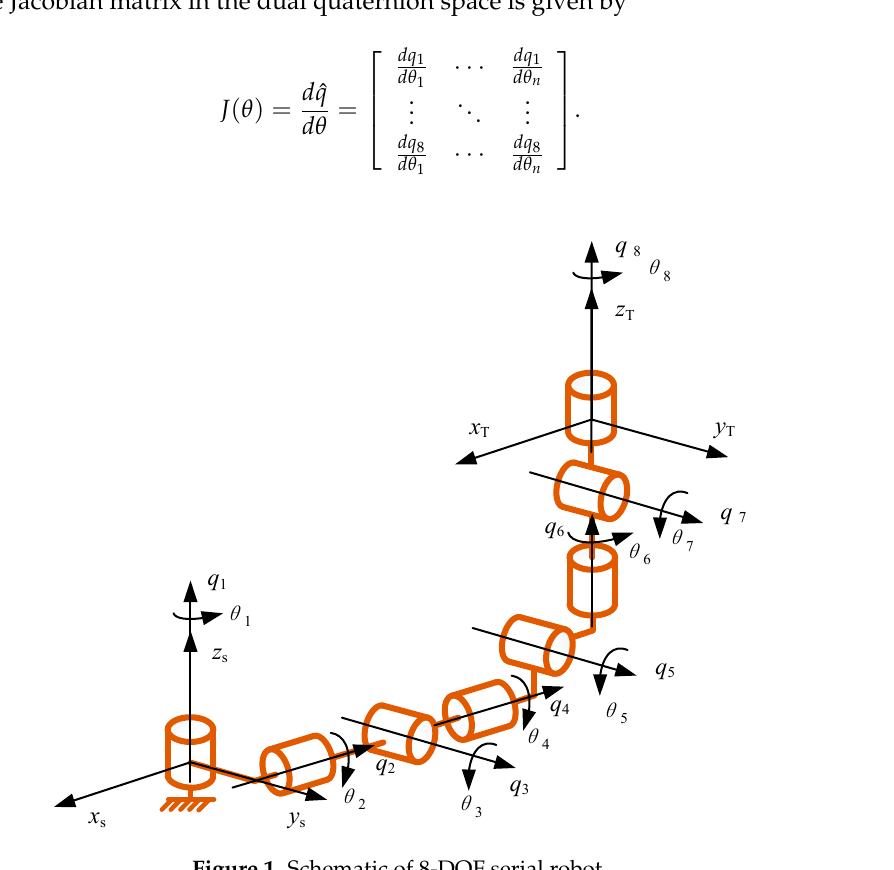
Figure 1. Schematic of 8-DOF serial robot.